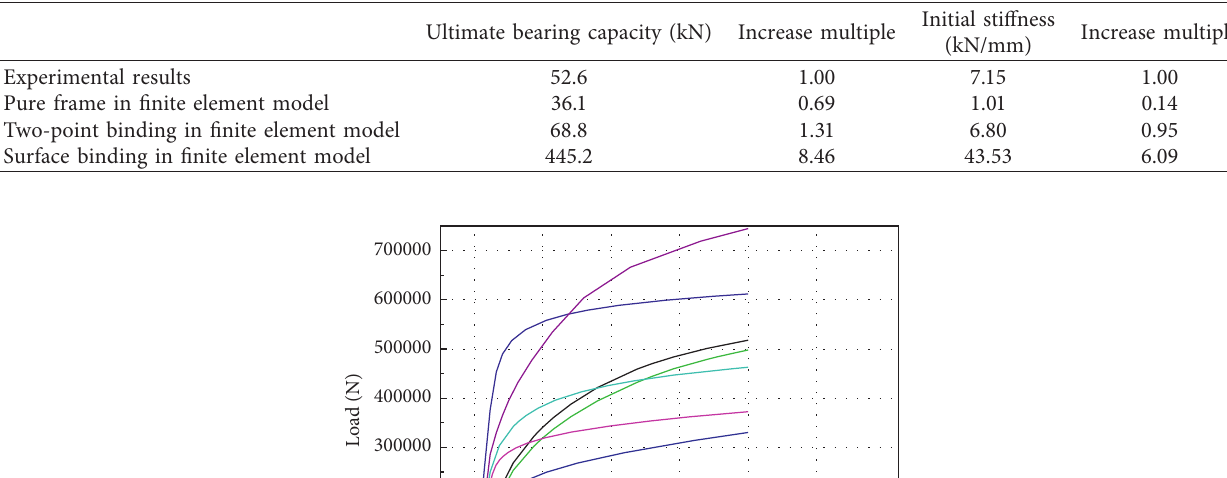
Table 5: Comparison of the ultimate bearing capacity and initial stiffness for QY-1.